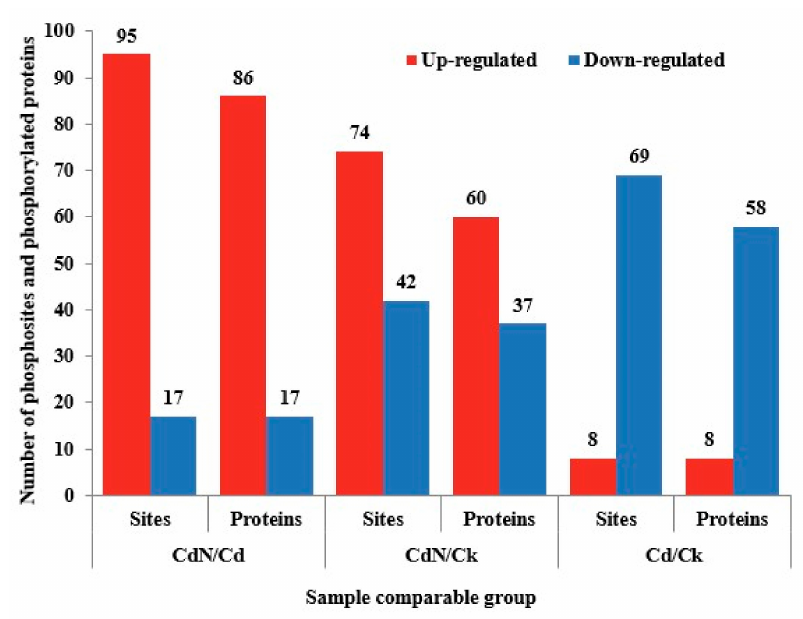
Figure 3. The di ff erentially expressed phosphosites and phosphorylated proteins (after being normalized) in the Cd / CK, Cd + N / Cd and Cd + N / CK